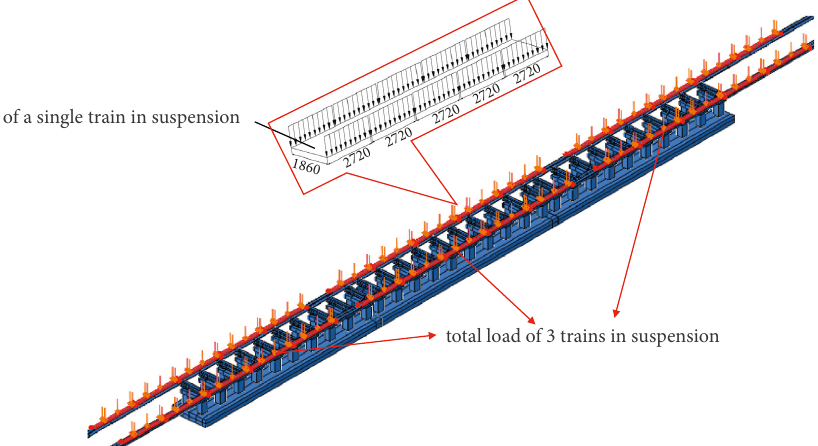
Figure 7: Suspended load diagram.